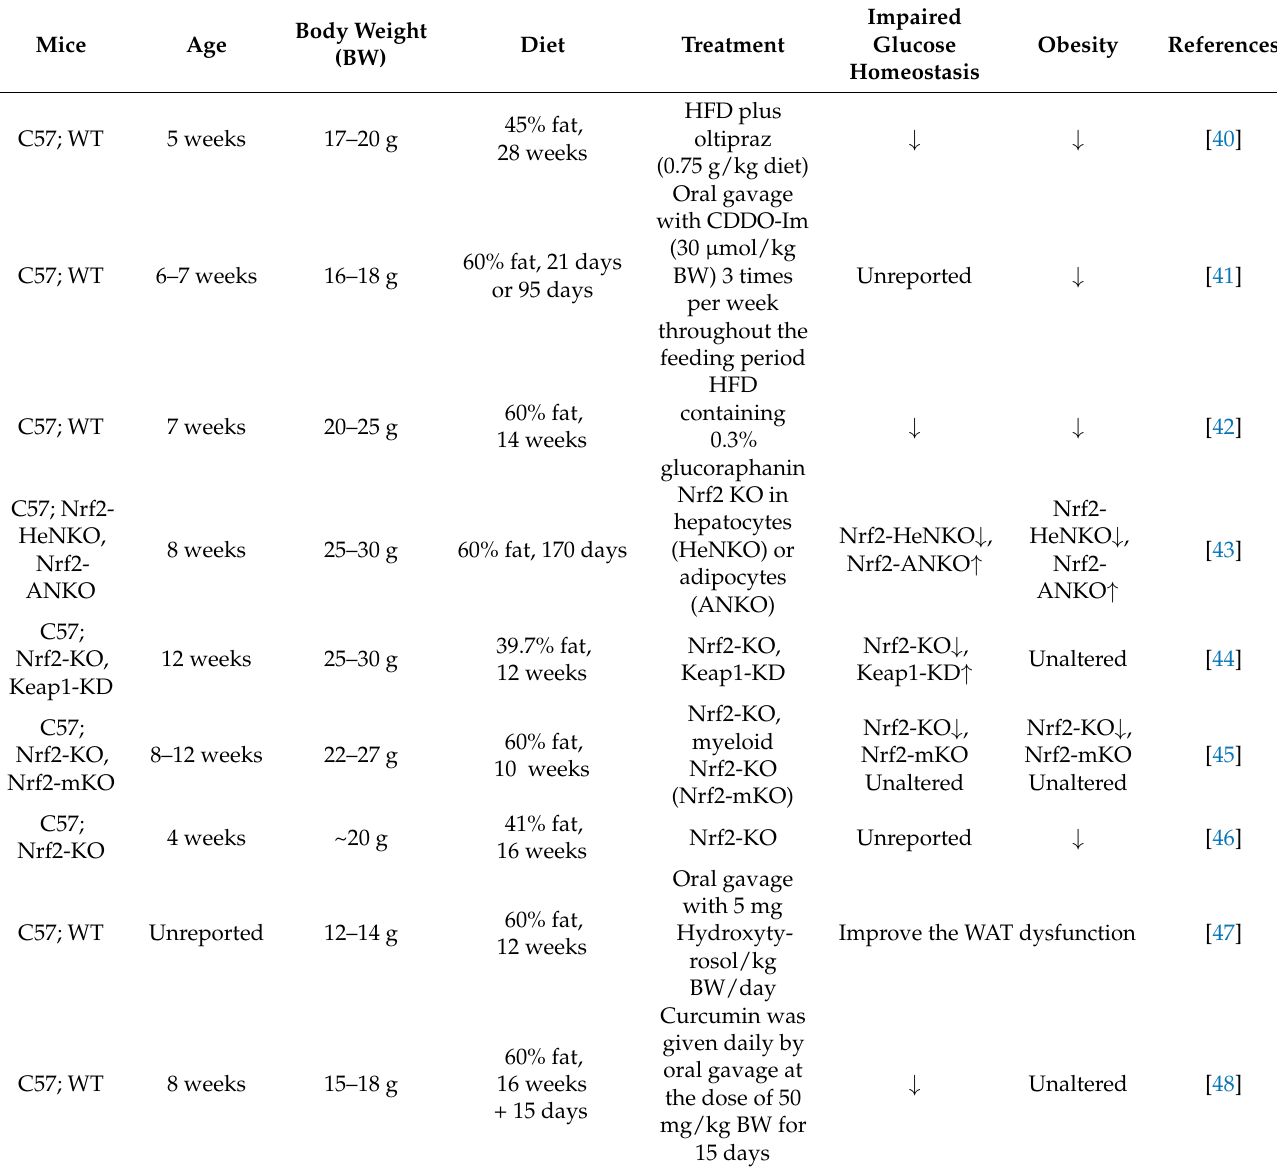
Table 1. Different roles of Nrf2 signaling in animal models of diet-induced obesity